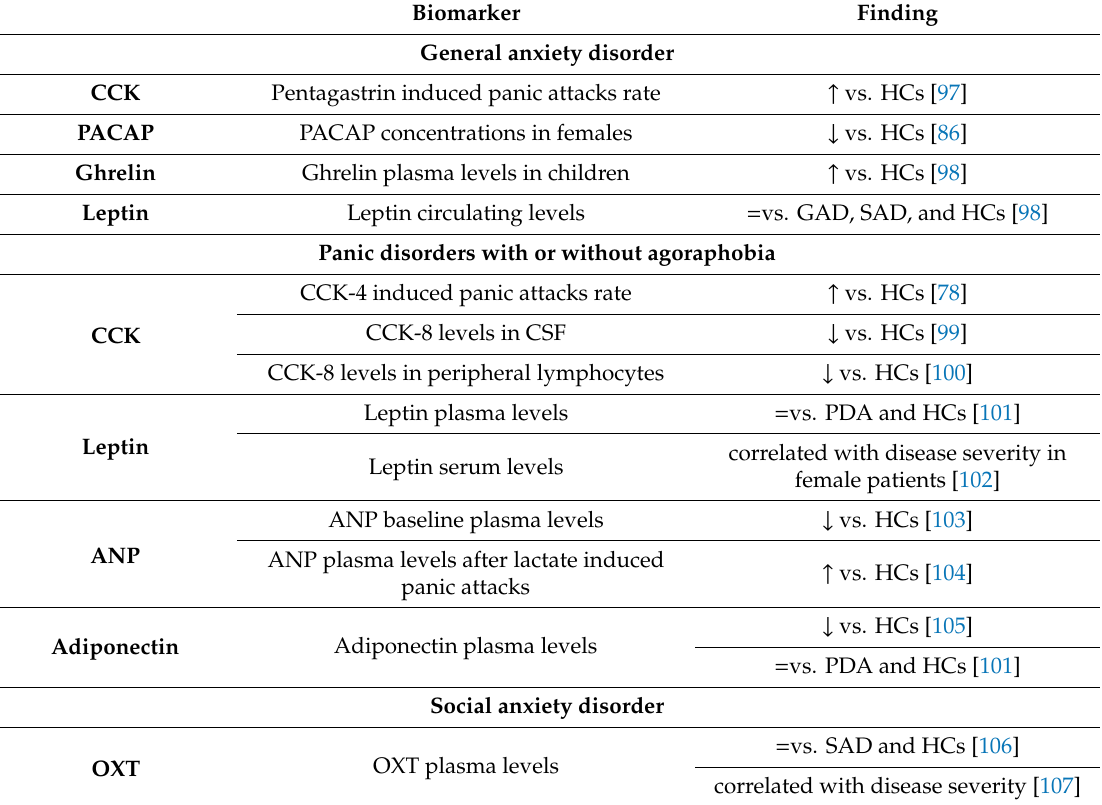
Table 2. Summary of the literature findings related to the neuropeptides involved in GAD, PDA, and SAD. Biomarker Finding General anxiety disorder CCK Pentagastrin induced panic attacks